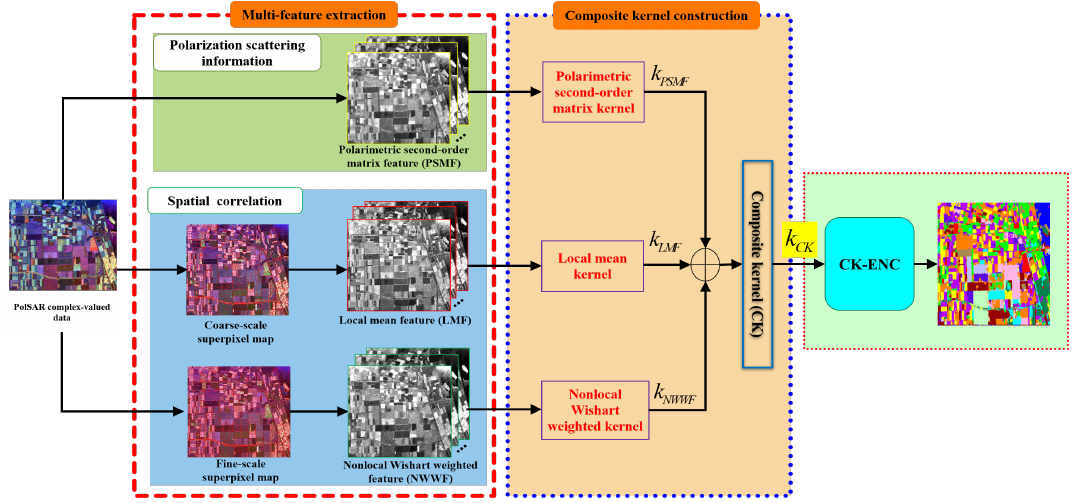
Figure 1. Framework of the proposed